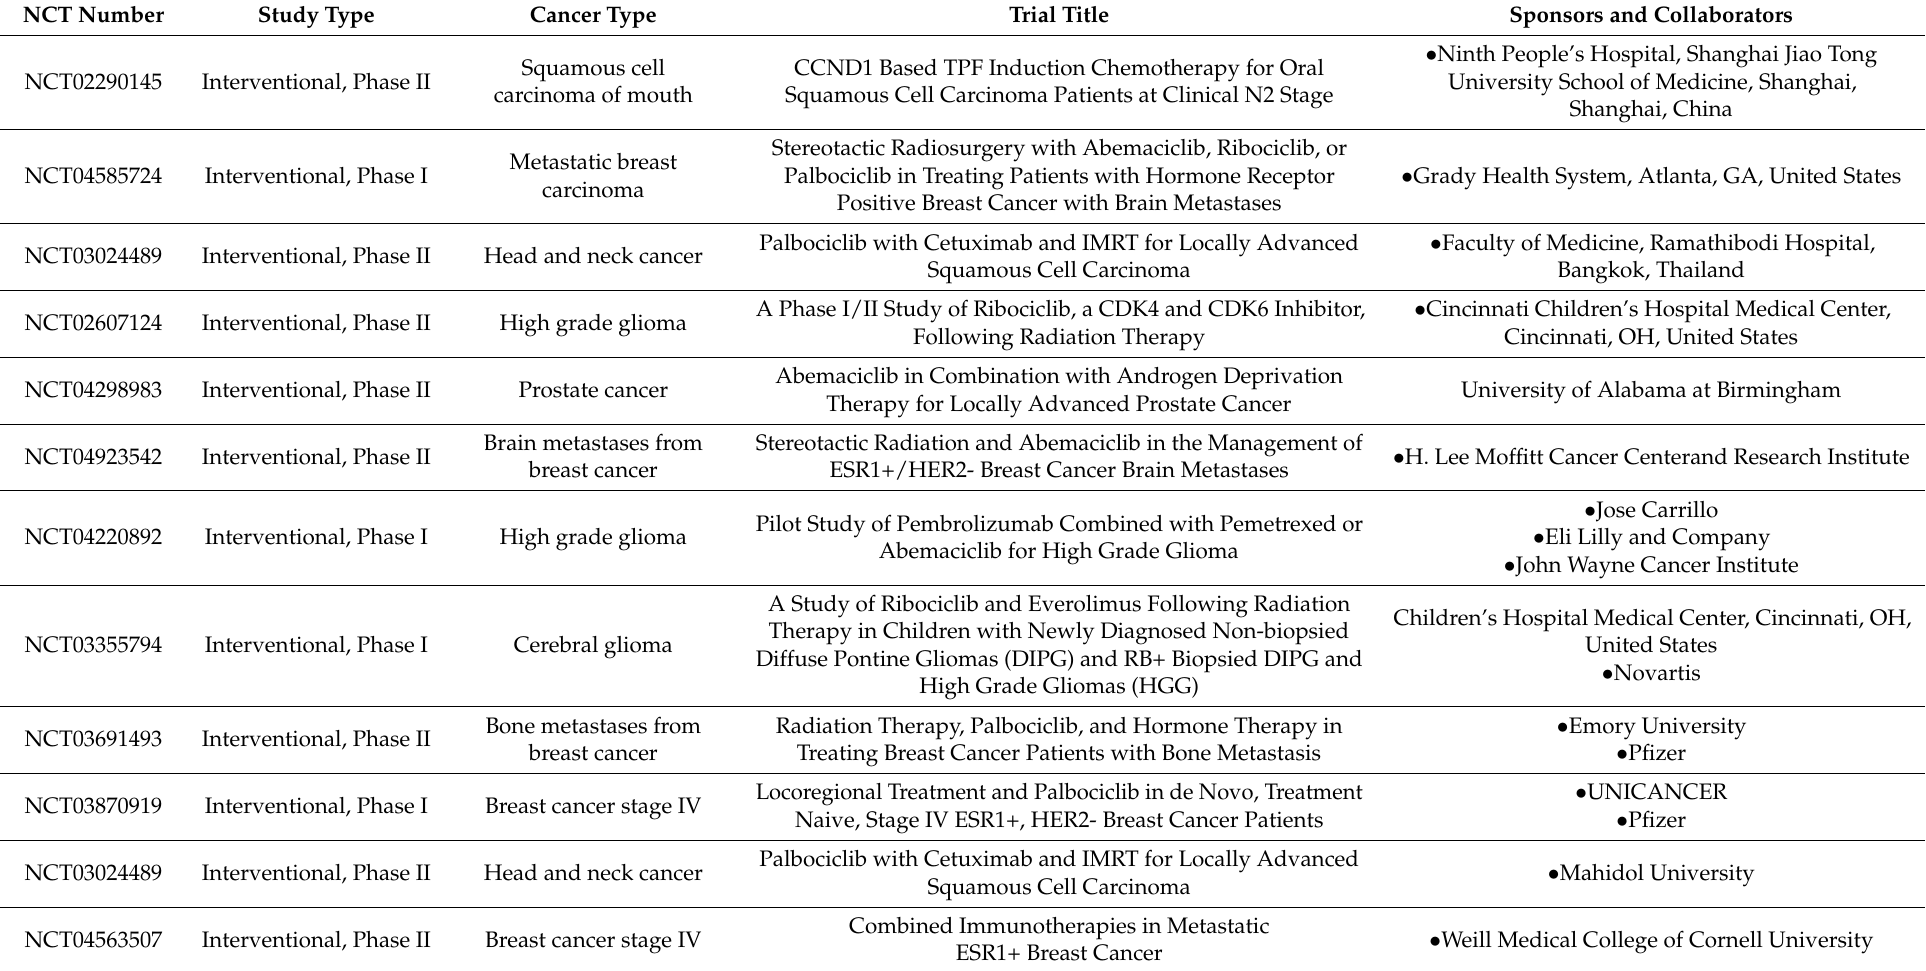
Table 2. Ongoing clinical trials evaluating combination of CDK inhibitors and RT in different